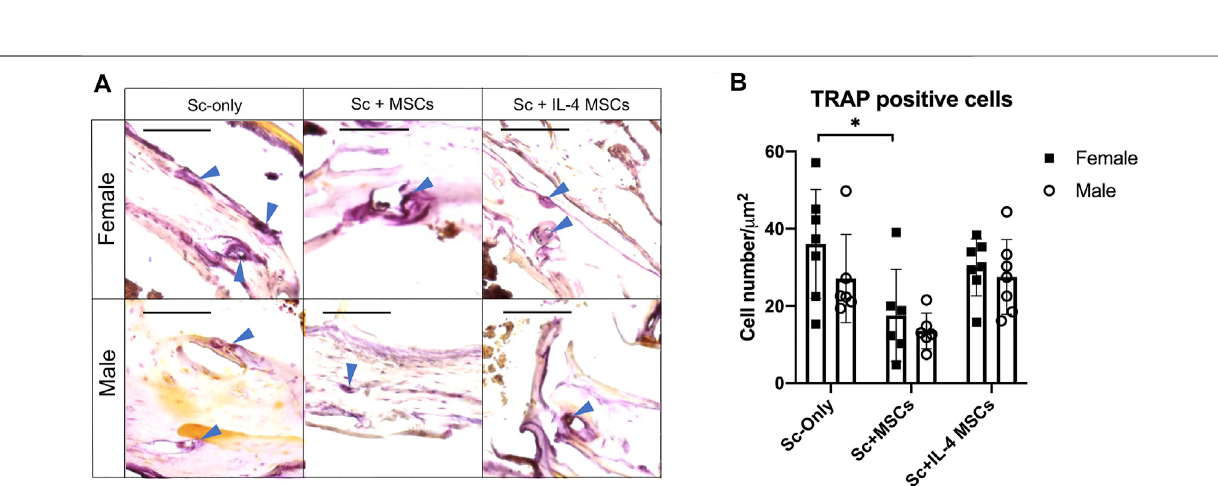
FIGURE 4 | ALP staining and analysis of critical size bone defect healing in female and male mice. (A) The ALP-stained bone defects representative images of all groups after 6 weeks with 200 times magni fi cation. (B) ALP positive area calculated.